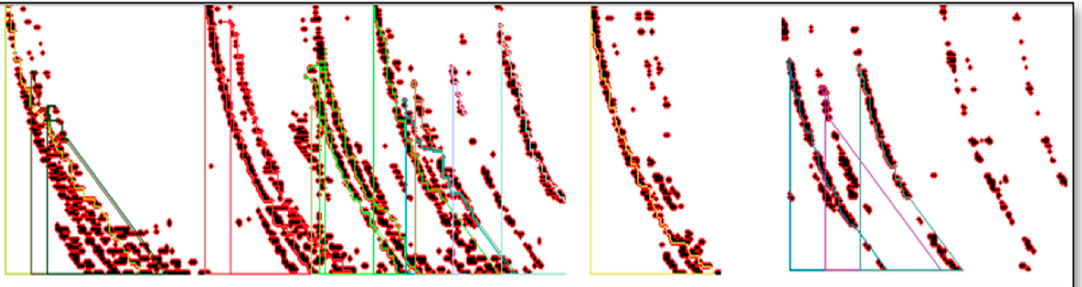
Figure 6. The segmentation of an input image of a 4-s duration observation into a grid line to extract 293 the corresponding information. 294